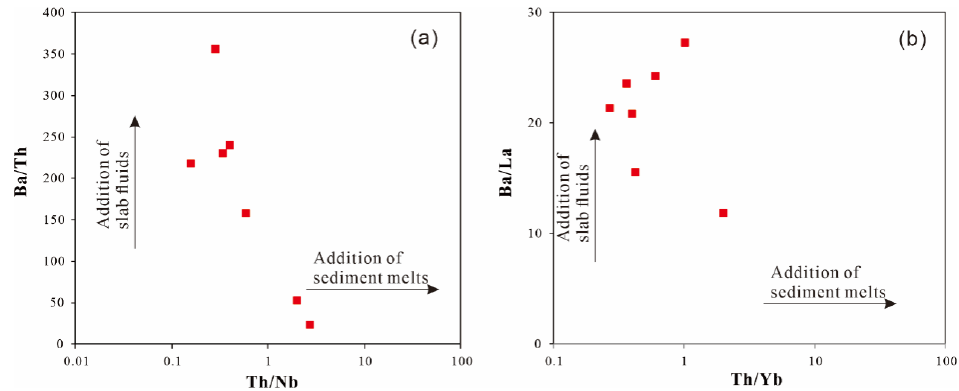
Figure 11. Ba/Th vs. Th/Nb ( a ) modified from Hanyu, Tatsumi [78]) and Ba/La vs. Th/Yb; ( b ) modified from Woodhead et al. [81]) diagrams for Yuejingshan gabbro samples.